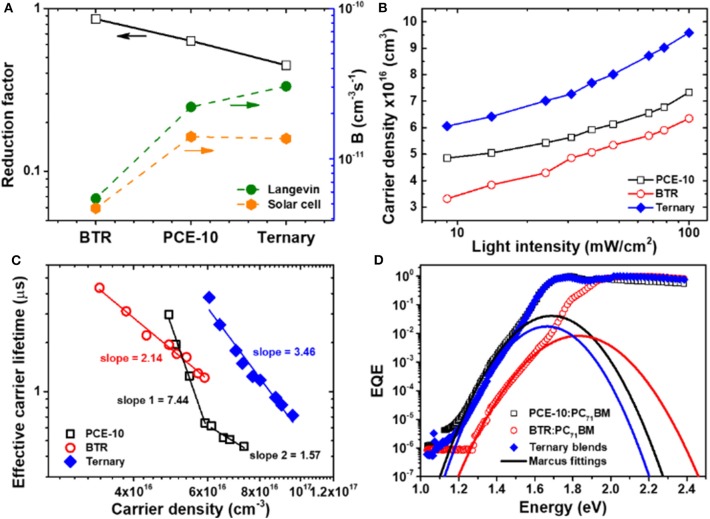
(A) Reduction factor γ, recombination rate constant β and Langevin rate constant βL determined on BHJ-OSCs with PCE-10 and BTR binary blends and PCE-10:BTR:PC71BM ternary blends. (B) Density of photocarriers as a function of light intensity in binary and ternary devices. (C) Effective carrier lifetime vs. carrier density characteristics of solar cells alongside linear fittings used to assess the recombination order. Inset texts: slopes of linear fittings. (D) Fourier transform photocurrent spectra (FTPS) of binary and ternary OSCs together with fittings with Marcus equation.